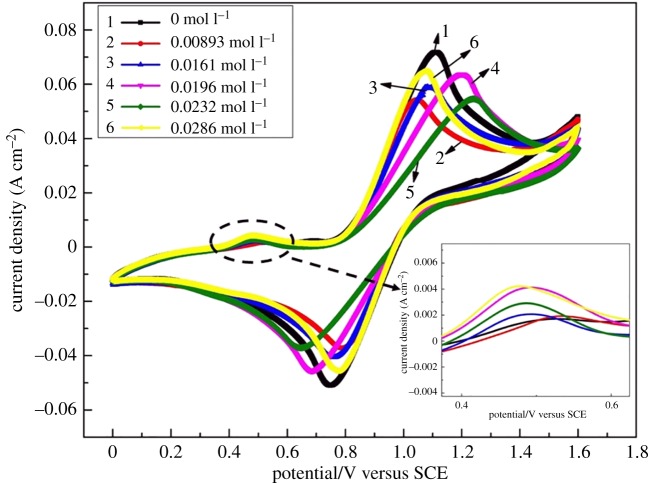
CV curves of 1.6 M VOSO4 at the scan rate of 10 mV s−1 with different concentrations of Fe(III).